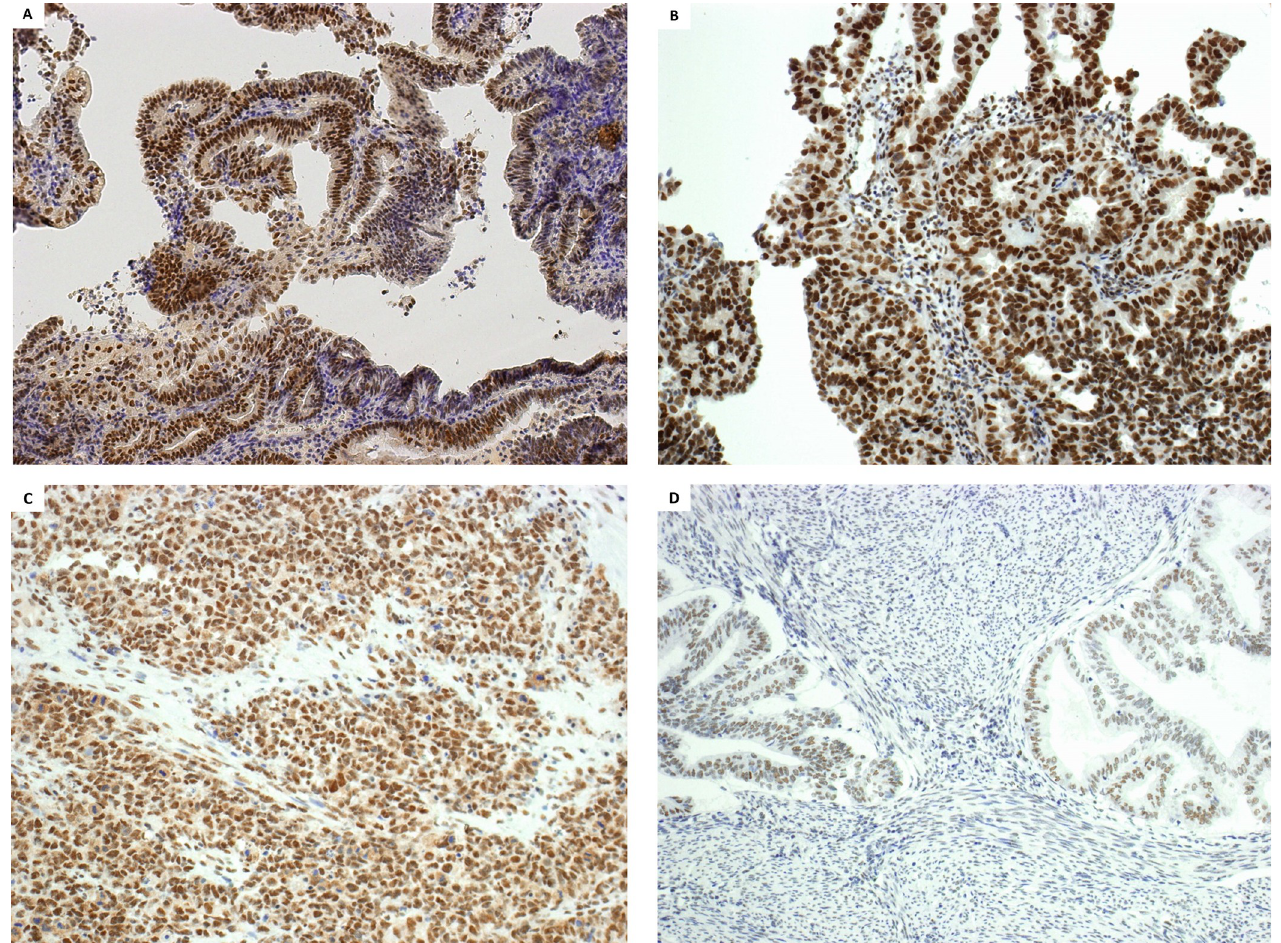
Fig 1. Representative NRF2 immunostaining in endometrial tumors. Immunohistochemical assay using NRF2 (clone A-10, SantaCruz) monoclonal antibody, revealed with Leica Bond Polymer Refine Detection System Kit. 10X objective. A : endometrioid grade I, copy number low -like tumor–stage IB. NRF2 high case. B : serous carcinoma copy-number low -like tumor, stage IIIC2 –NRF2 high case. C : carcinosarcoma, copy number high -like tumor–stage IB. NRF2 intermediate case. D . endometrioid grade I, copy number low- like tumor–stage IB. NRF2 negative/low case. Note that: A : sample with NRF2 activating mutations ( KEAP1 p.R336 �